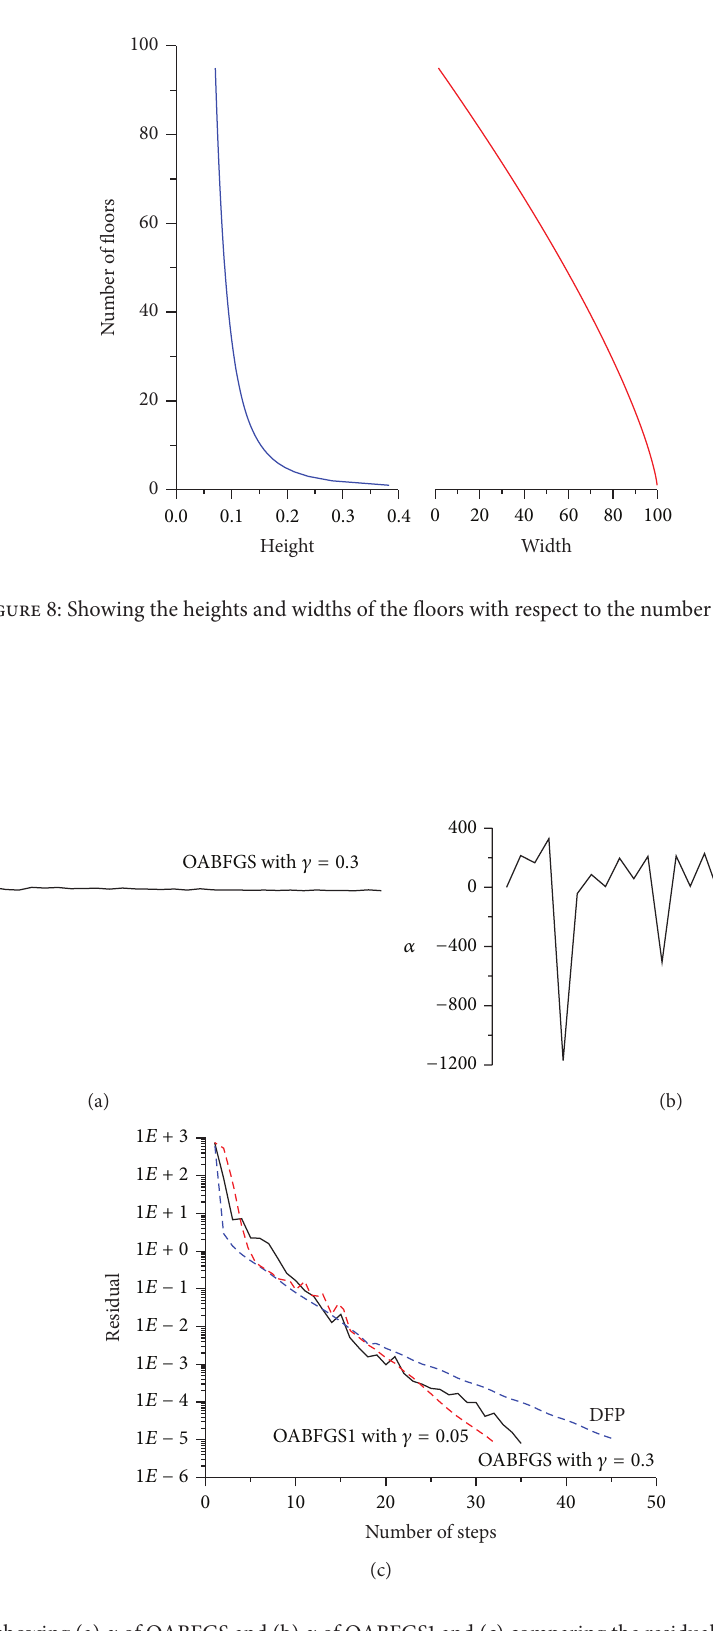
Figure 9: For Example 4, showing (a) 𝛼 of OABFGS and (b) 𝛼 of OABFGS1 and (c) comparing the residuals obtained by the DFP, OABFGS, and